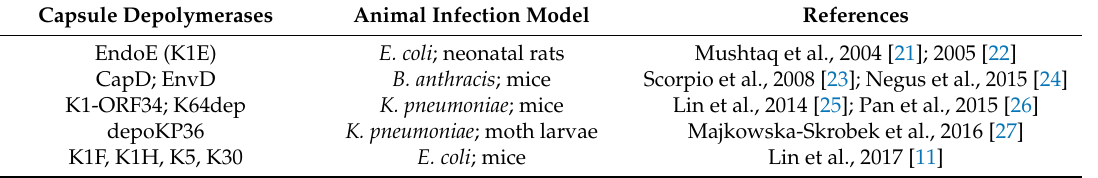
Table 1. In vivo studies of capsule depolymerases in animal infection